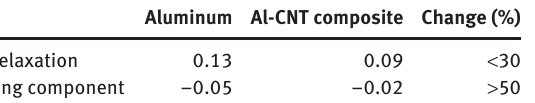
component of aluminum and Al-CNT composite.